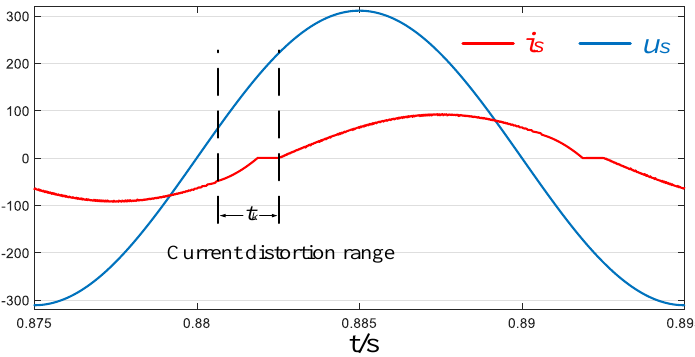
Figure 19. Simulation waveforms of grid voltage and input current when i s lags u s by 45°.